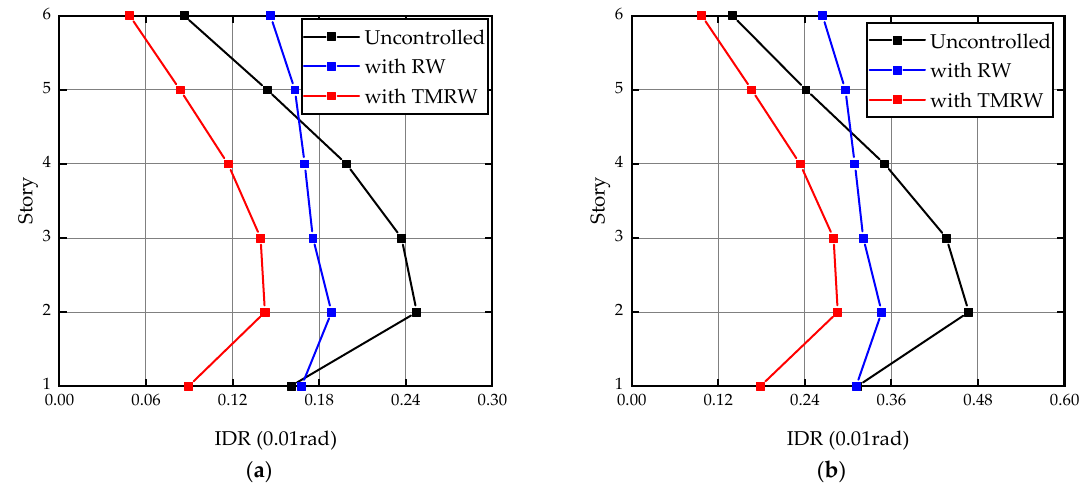
Figure 11. Comparison of the IDRs under Wenchuan earthquake excitation: ( a ) 0.1 g case; ( b ) 0.2 g case.